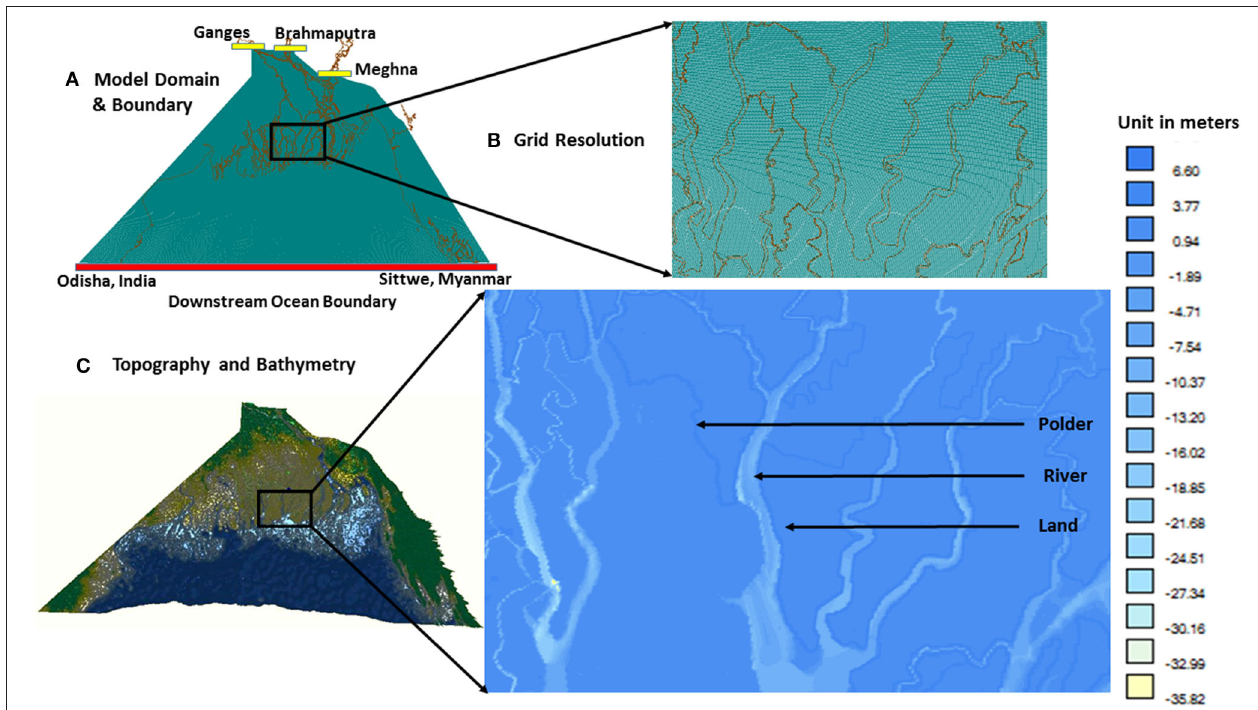
FIGURE 2 | (A) Model domain and boundary (upstream stations are yellow and downstream is red); (B) grid resolution; (C) model bathymetry with the detailed representation of coastal features such as polder, river, and